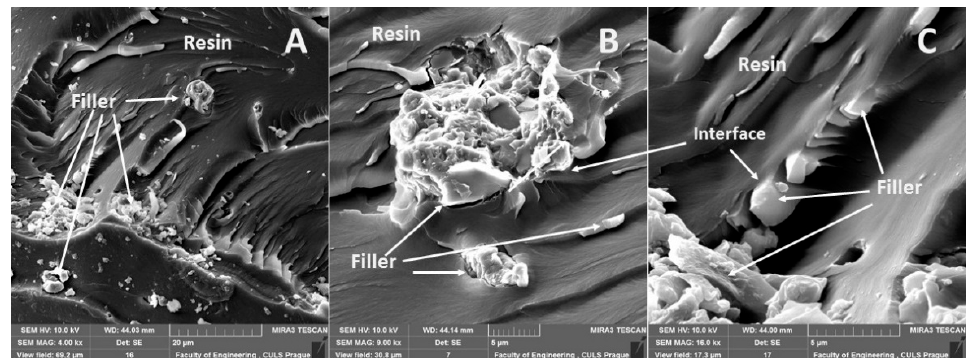
Figure 6. SEM micrographs—static tensile test of composite material: ( A ) fracture surface of adhesive E5/TFF/100:26/CaCO 3 (mag 4.0k×), ( B ) detailed view of fracture surface of adhesive E5/TFF/100:26/CaCO 3 (mag 9.0k×), ( C ) detailed view of fracture surface of adhesive E5/TFF/100:26/CaCO 3 (mag 16.0k×).